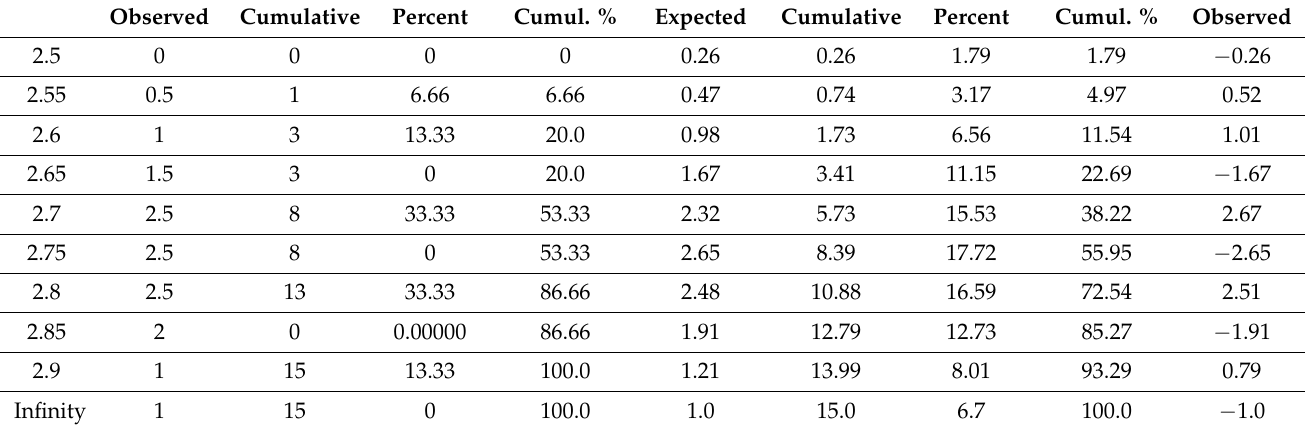
Table 1. Calculation of statistics criterion and distribution of a random variable over